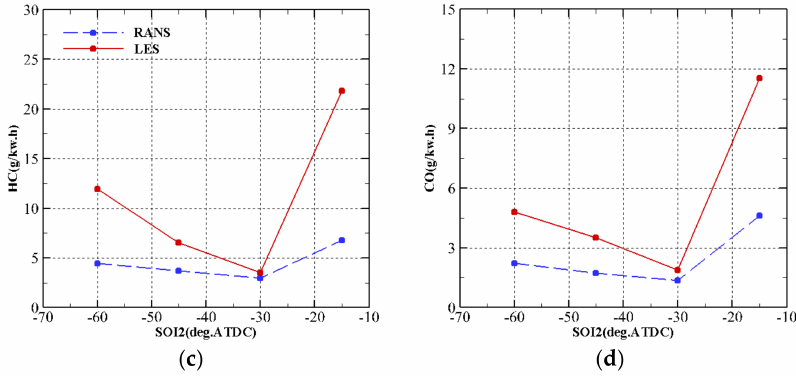
Figure 11. Comparison of LES and RANS model for: ( a ) NO x , ( b ) soot, ( c ) HC and ( d ) CO emissions with different SOI2 timings.